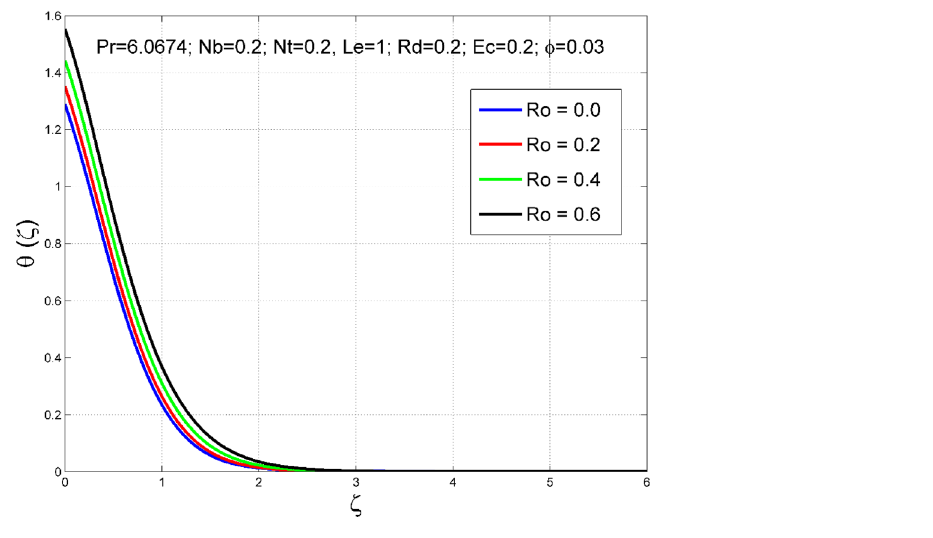
Figure 4. Effect of Ro on θ(ζ)